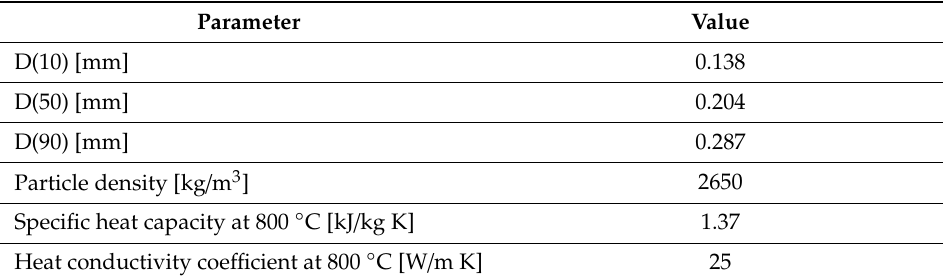
Table 4. Properties of